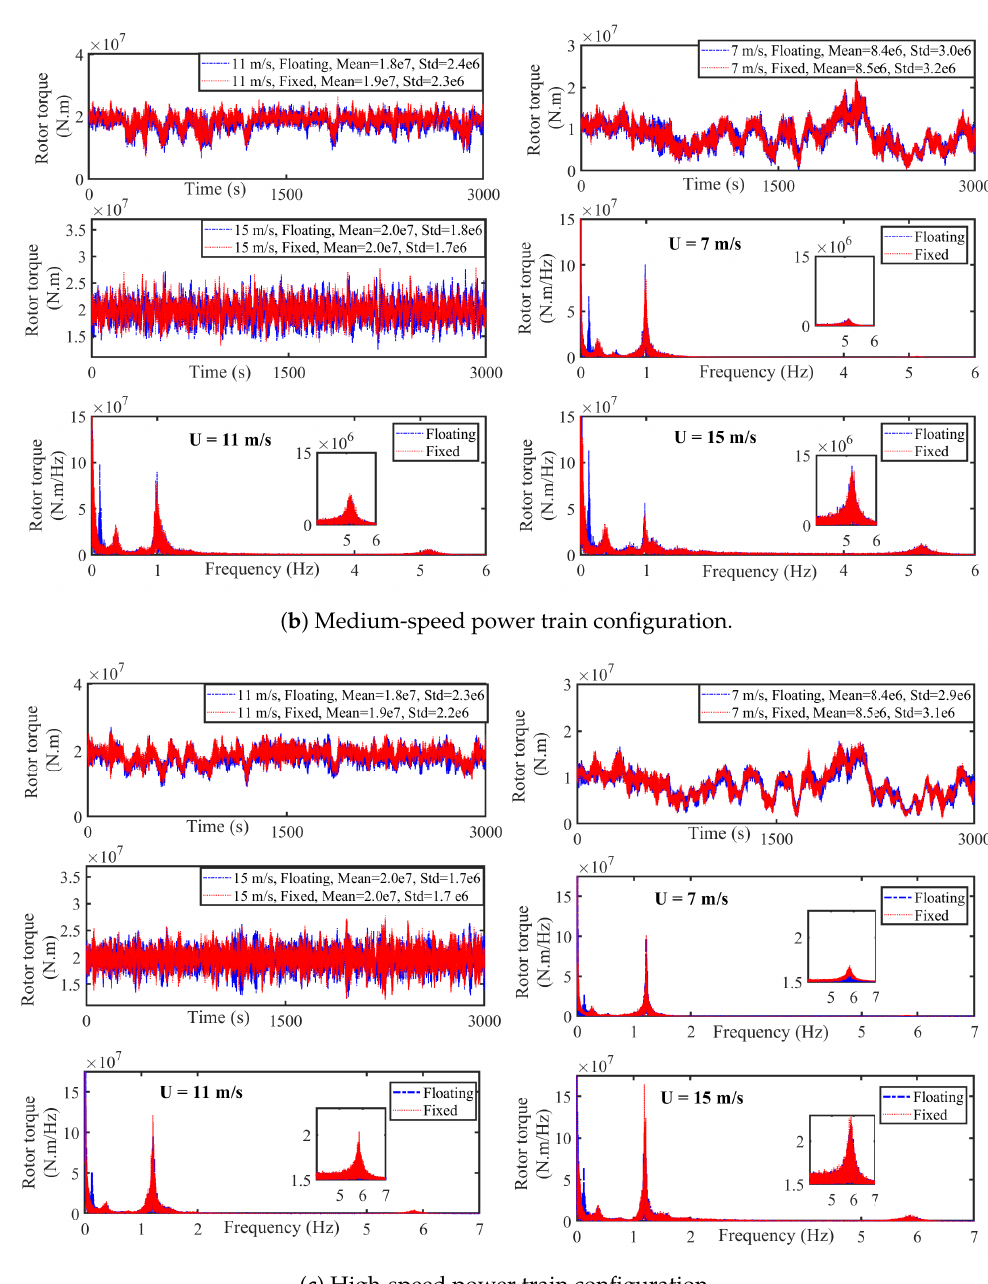
Figure 6. Rotor torque obtained from turbine-drivetrain coupled simulation in